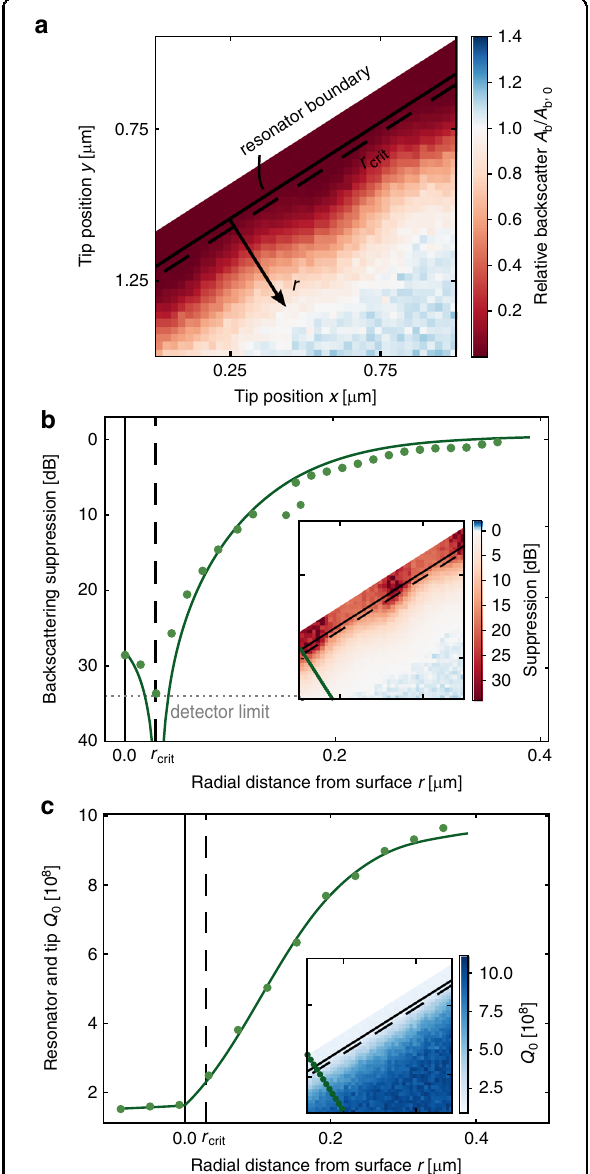
Fig. 4 Backscattering suppression and Q 0 in a high-Q resonator. a Backscattering amplitude measurement grid, with the resonator boundary and critical tip coupling line annotated. b Radial dependence of the backscattering suppression (circles, measurement; line, fi t) along a radial line. The noise of the photodetector is indicated by the dotted grey line. Inset: suppression for all positions. The critical tip coupling at which the maximum suppression occurs is annotated. The measured suppression is limited by the photodetector noise. c Radial dependence of resonator and tip quality factor Q 0 along a radial line. Inset: Q 0 for all